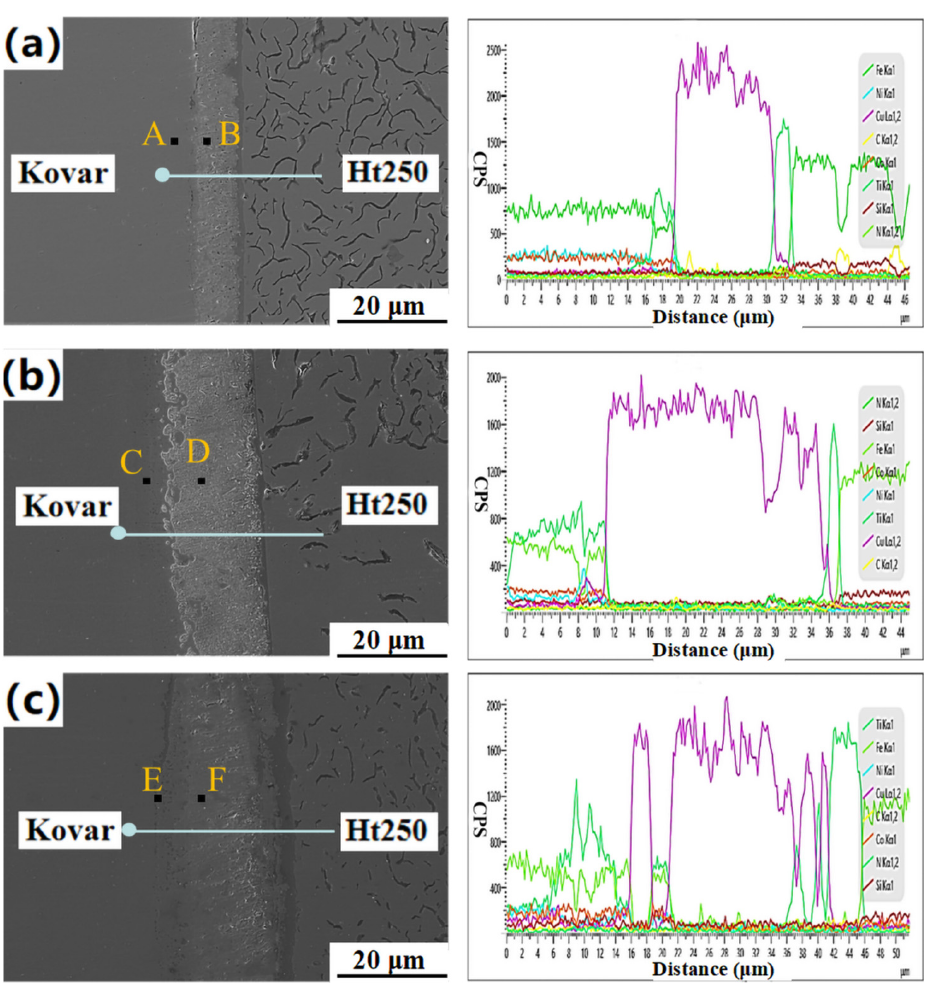
Figure 8. The microstructure of Kovar/Cu/Ti/Ht250 joints at ( a ) 940 °C, ( b ) 970 °C, ( c ) 1000 °C, ( d ) 1030 °C and ( e ) 1060 °C.